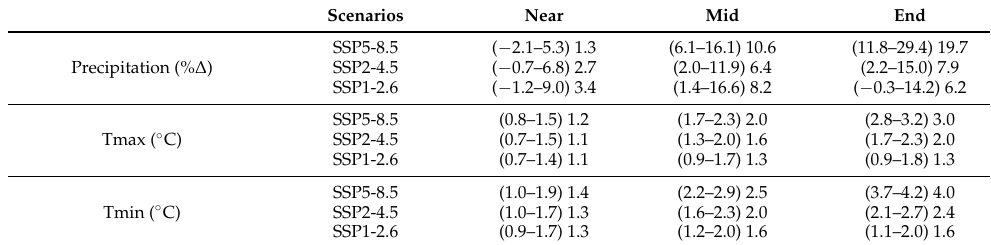
Table 8. Mean annual areal-averaged future climate change over UASB for three time periods and two scenarios.